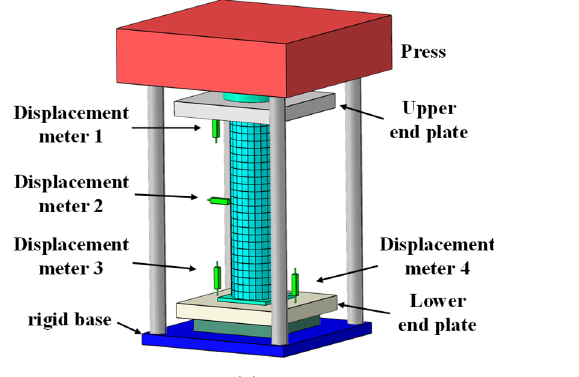
Table 2. Material properties of concrete .